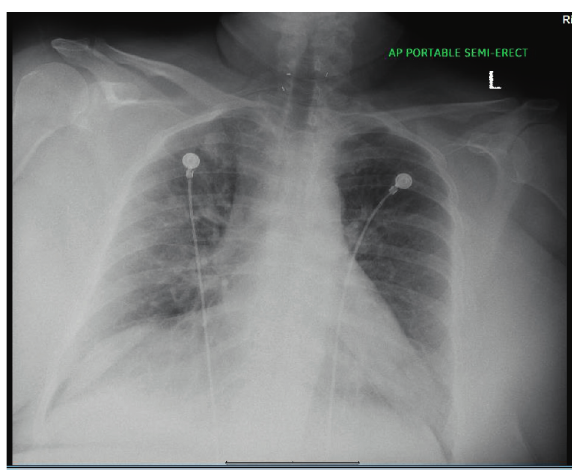
Figure 1: Chest X-ray showing bilateral infiltrates.